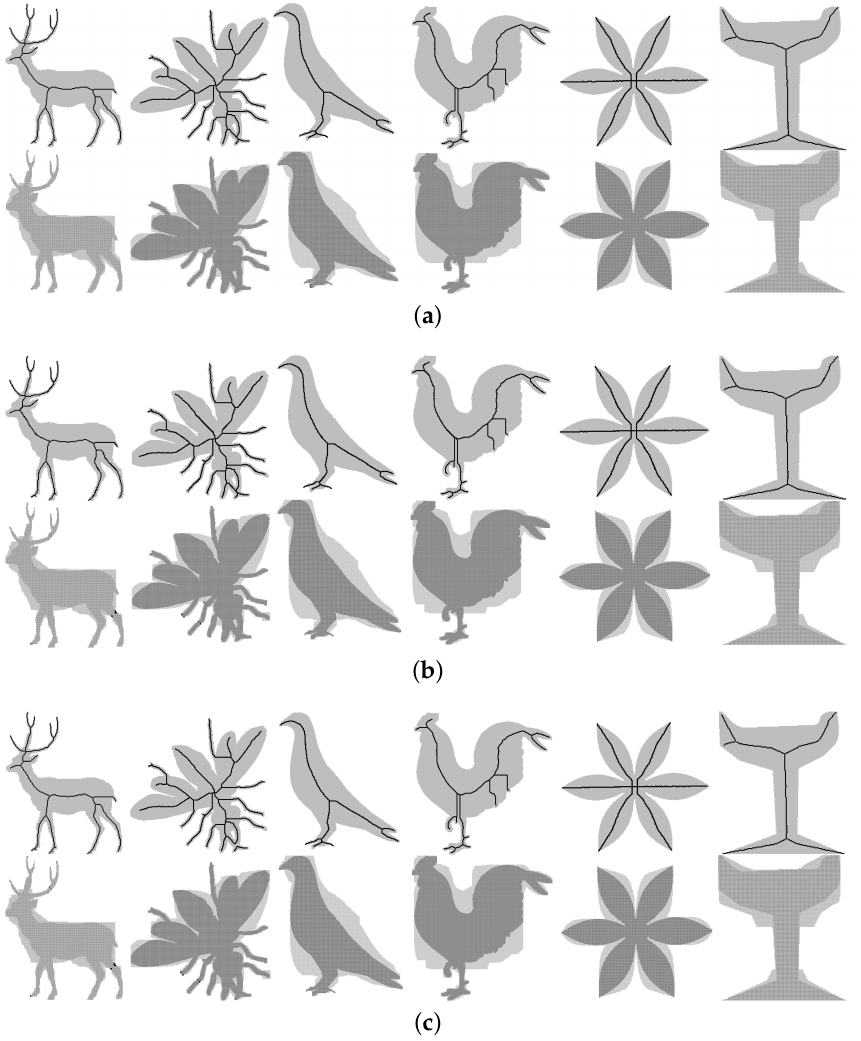
Figure 17. Results of some patterns from the MPEG7 CE-Shape-1 dataset are obtained by the three fully-parallel thinning algorithms involved in the proposed approach without the RHDP process for comparisons. Here, the thinning and reconstruction results are placed on the first and second row, respectively. The phenomenon of over-reconstruction is very obvious. ( a ) CH [9]; ( b ) AW [16]; ( c ) Rockett